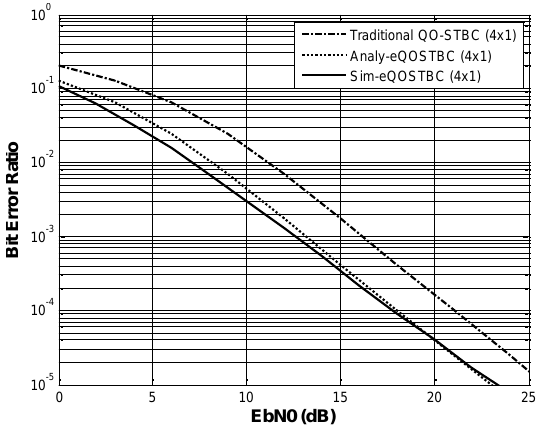
Figure 7: Performance comparison of analytical and simulation results